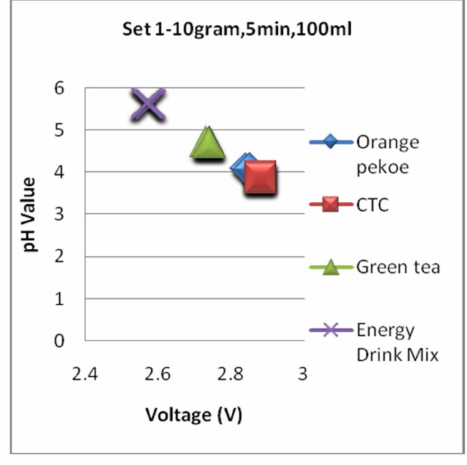
Figure 17. The voltagevs. pH plotting for Set 1.